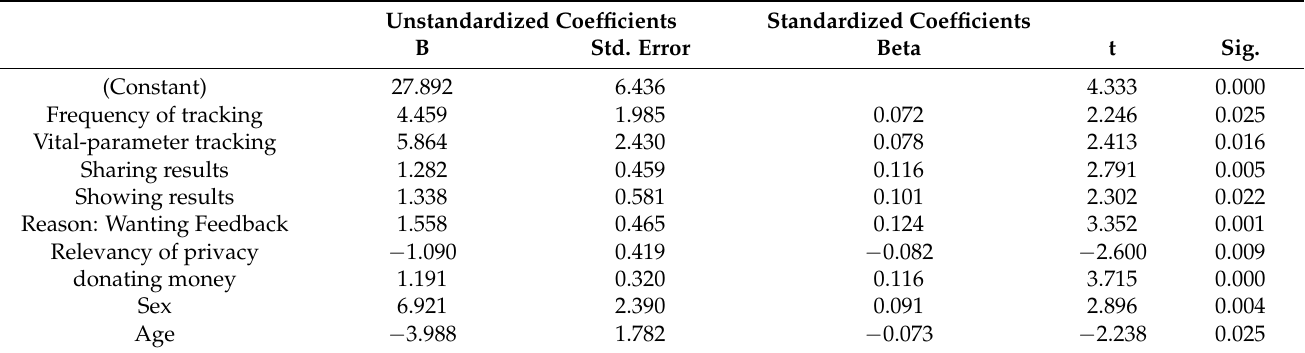
Table 2. Influencing parameters on data donation probability.